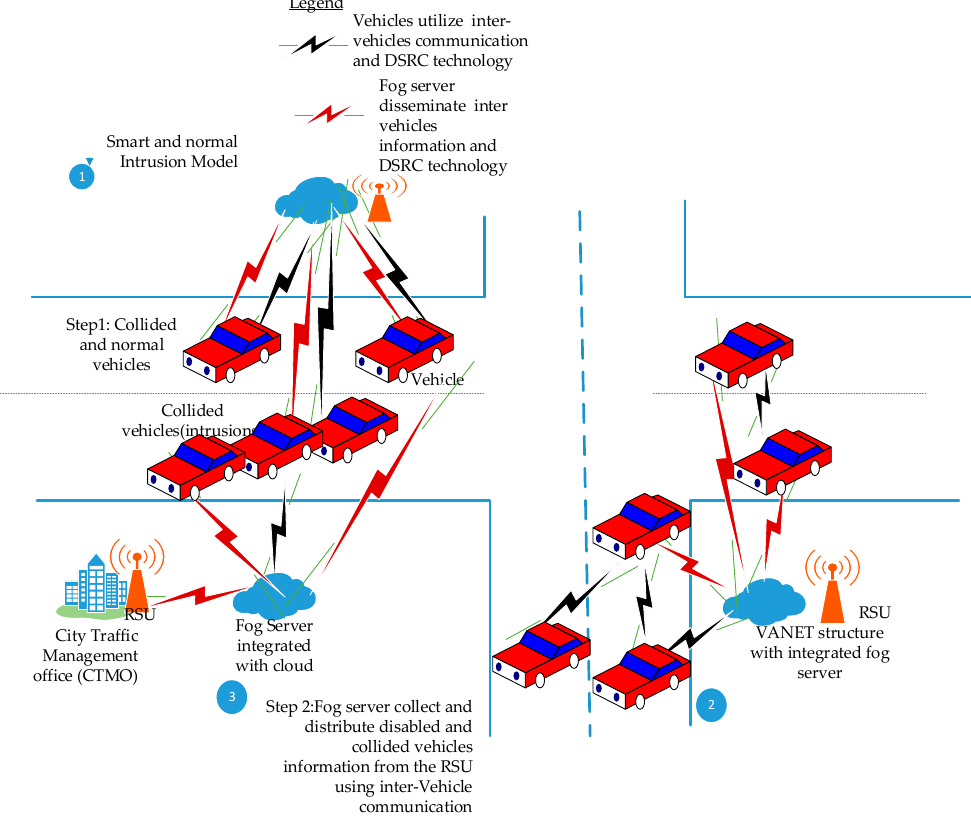
Figure 4. Proposed Secure Intelligent Vehicular Network using Fog Computing (SIVNFC) system architecture prevention model.